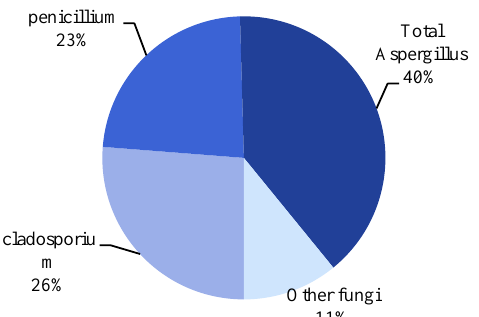
Figure 1. Percentage of fungi isolated in winter seasons sampling water distribution